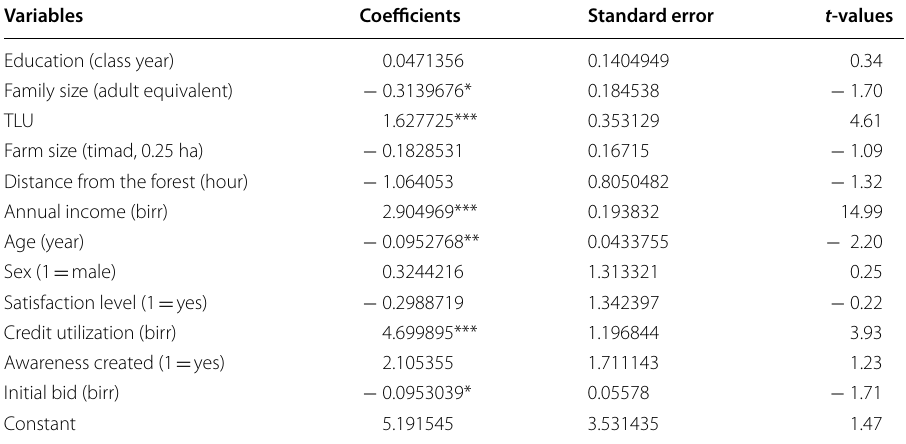
Table 6 Determinants of willingness to pay results from the Tobit model . Source: Author’s computation, 2021